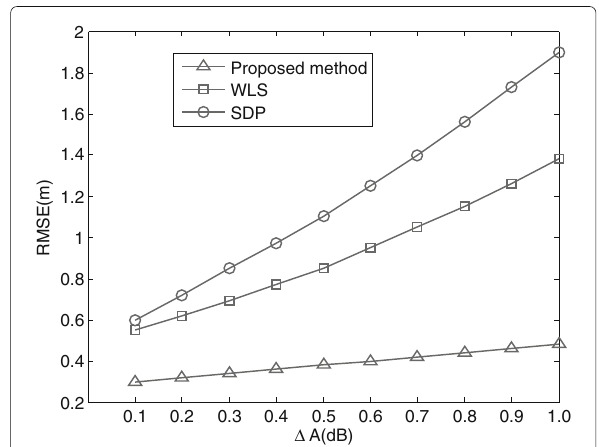
Fig. 13 Localization accuracy for three compared methods when (cid:6) A varies from 0.1 dB to 1.0 dB